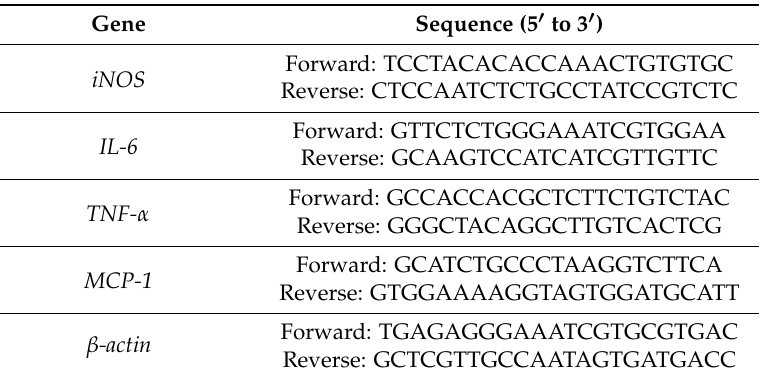
Table 1. Primers used for the quantitative real-time